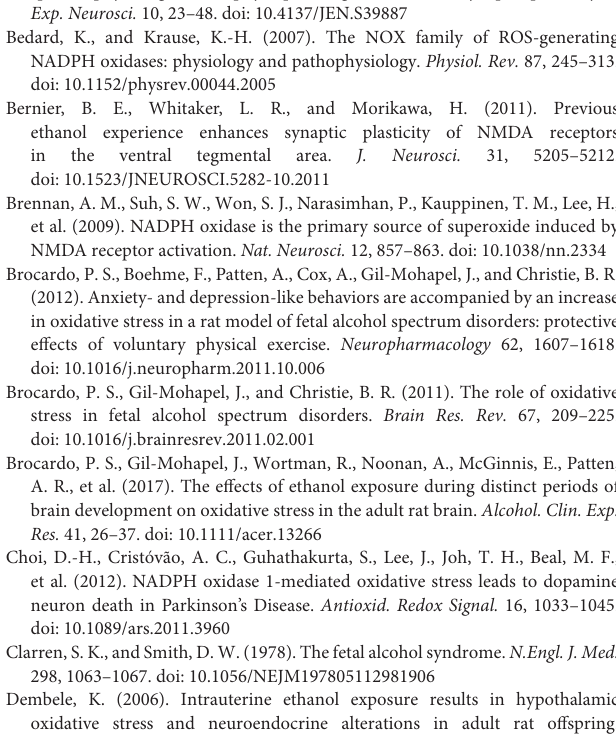
Supplementary Figure 1 | Daily consumption of liquid during mother’s treatment. Mothers were treated with water + sucralose (black dots) or ethanol 10% + sucralose (white dots) as is described in the methods section. Mothers that received ethanol treatment were also exposed to additional water consumption for 2h every morning (gray dots). Dot line depicts the day of birth (E21). Mean ± SEM, N =